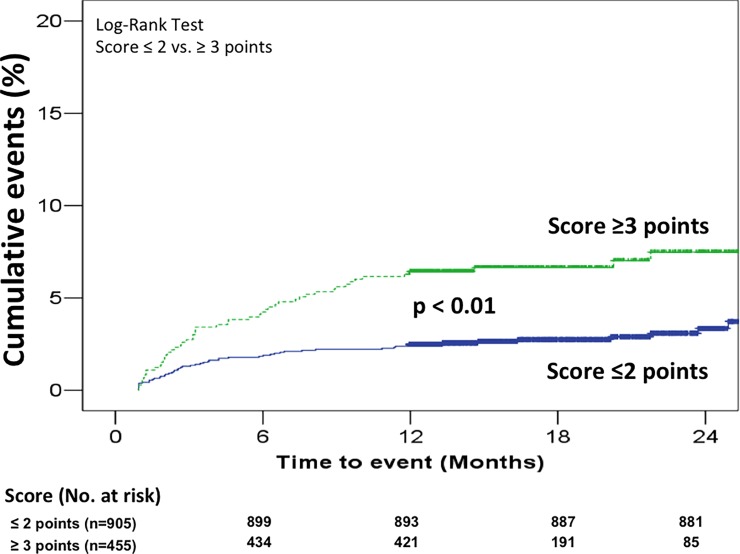
Cumulative incidence of occult cancer over 24 months attending score (≤2 vs. ≥3 points).Time-to-event data.